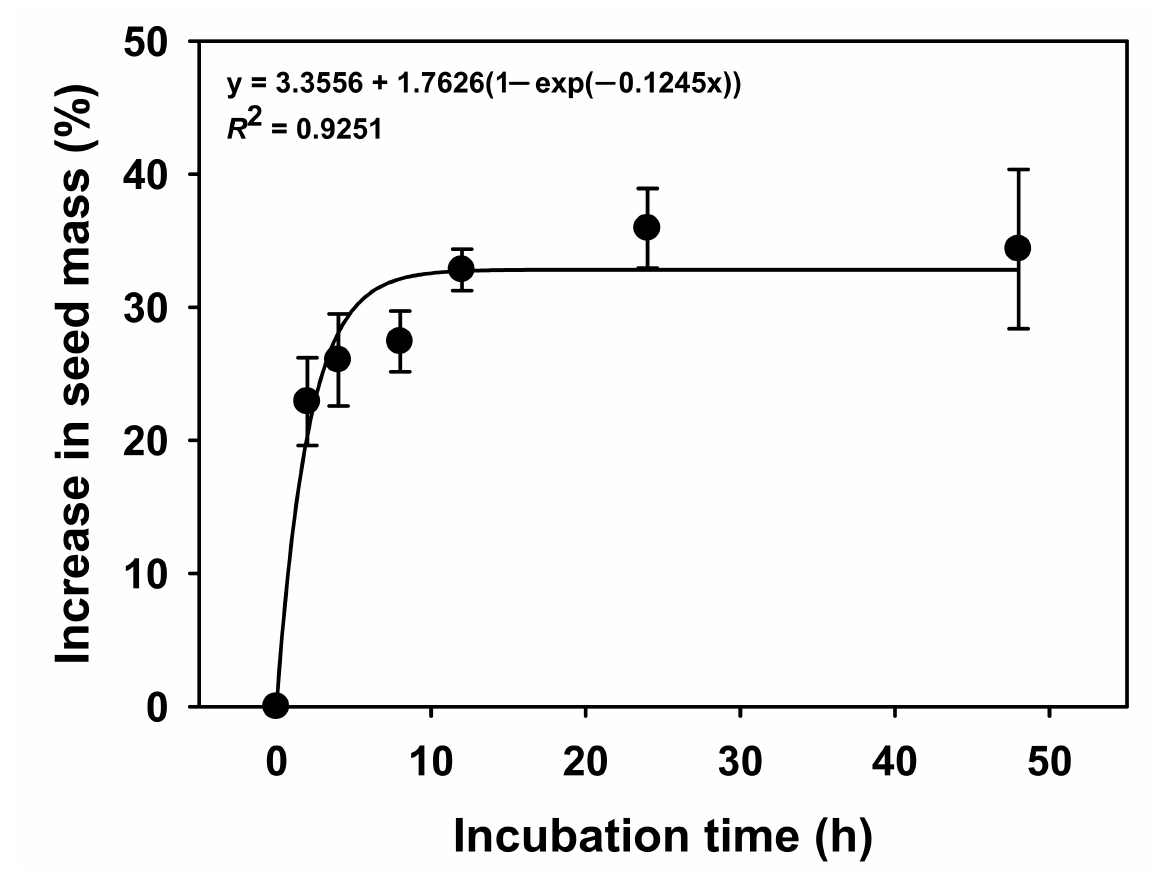
Figure 2. Water uptake by V. sibiricum seeds incubated at 21–26 ◦ C on filter paper moistened with distilled water for 0–48 h. Error bars indicate mean ± SE of four replicates.